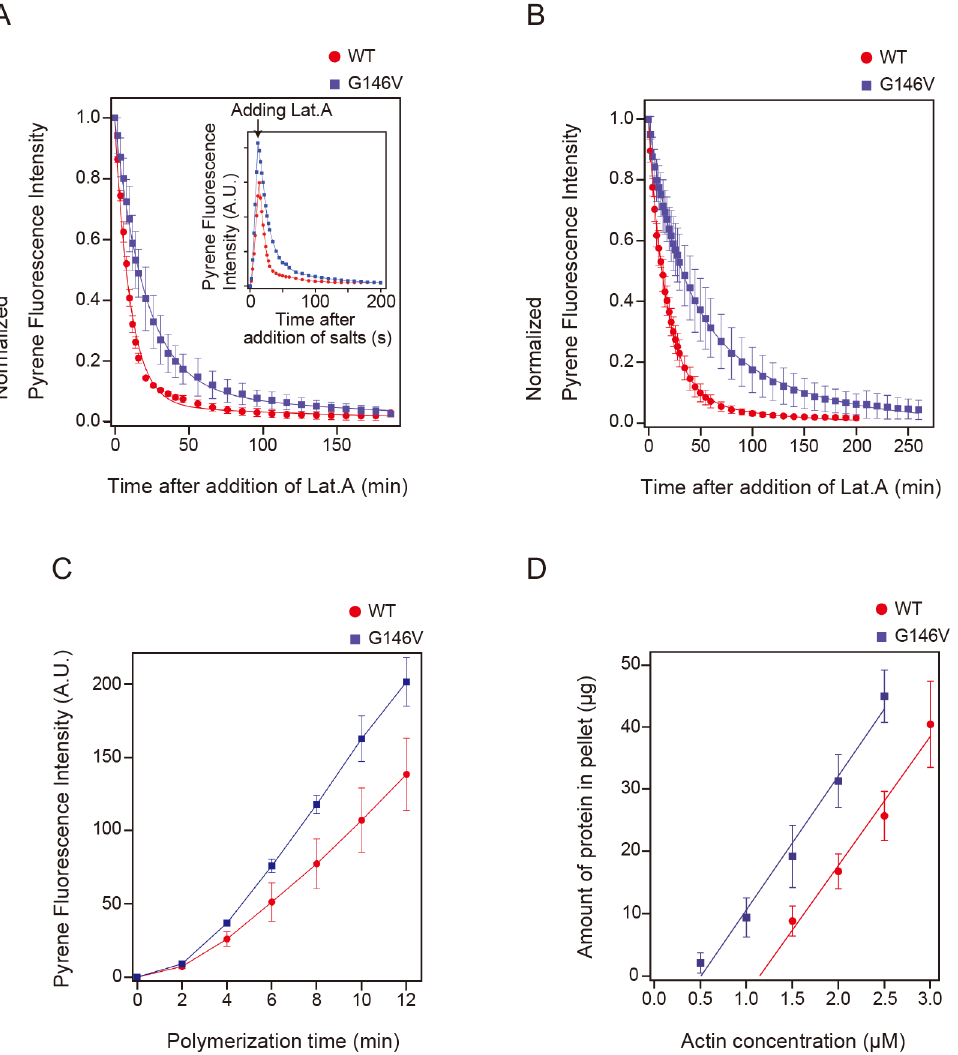
Fig 1. Polymerization and depolymerization of G146V and WT filaments. A 2 μ M solution of monomeric actin (20% labeled with pyrene) was polymerized for 12 min (A) or overnight (B) at 22°C. Depolymerization was then induced by adding 30 μ M latrunculin A. Data were fitted with a double- exponential equation, I(t) = f sexp(-t/ τ s) + (1 − f s)exp(-t/ τ f) [17]. The parameters f s and τ s respectively give the fraction and depolymerization rate of the slow- depolymerization population, and τ f gives the depolymerization rate of the fast-depolymerization population. Inset shows the raw data before